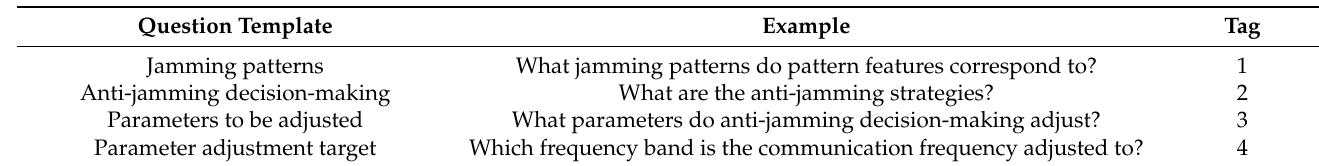
Table 1. Anti-jamming knowledge question answering (Q&A)